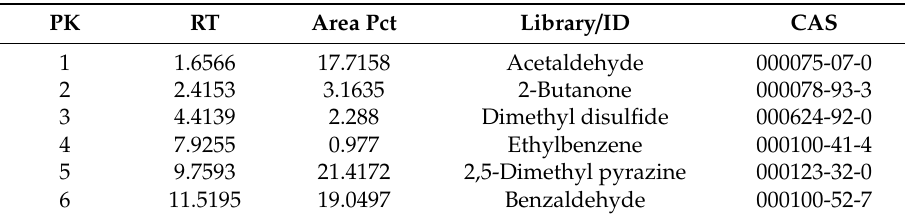
Table 1. Area percentage of the VOCs of the culture of V. dokdonensis MCCC 1A00493 through CAR / DVB